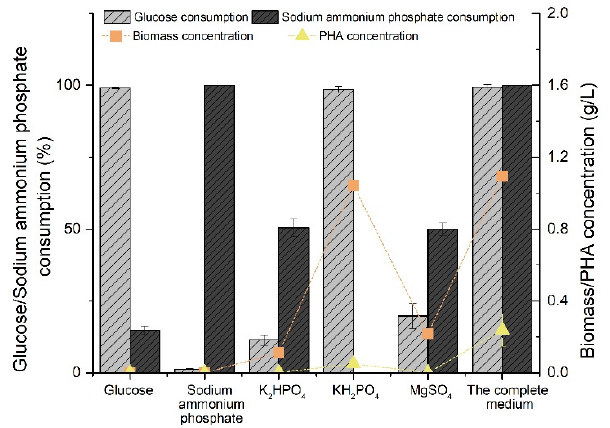
Figure 1. Effect of the absence of the selected component on the propagation medium and the complete propagation medium on the monitored variables.